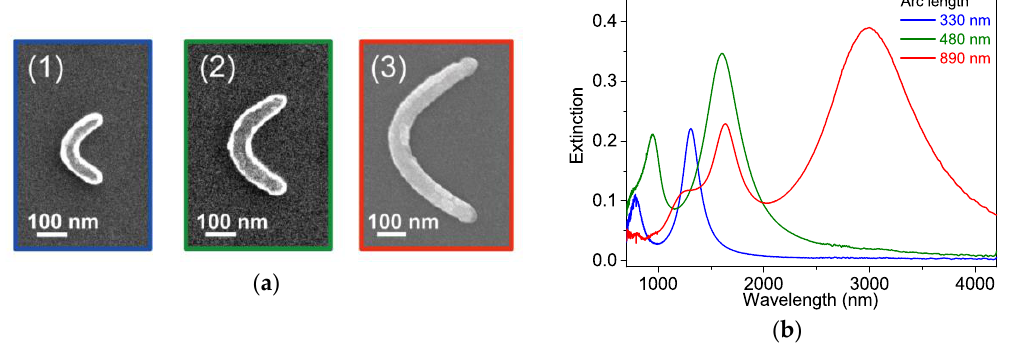
Figure 4. Schematics of the horizontal oscillation of free electrons in ( a ) curvilinear and ( b ) straight nanorods at 1630 nm.